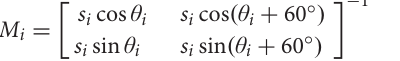
( Figure 1B ). We designate the phase of module i ’s bump as (cid:69) φ i